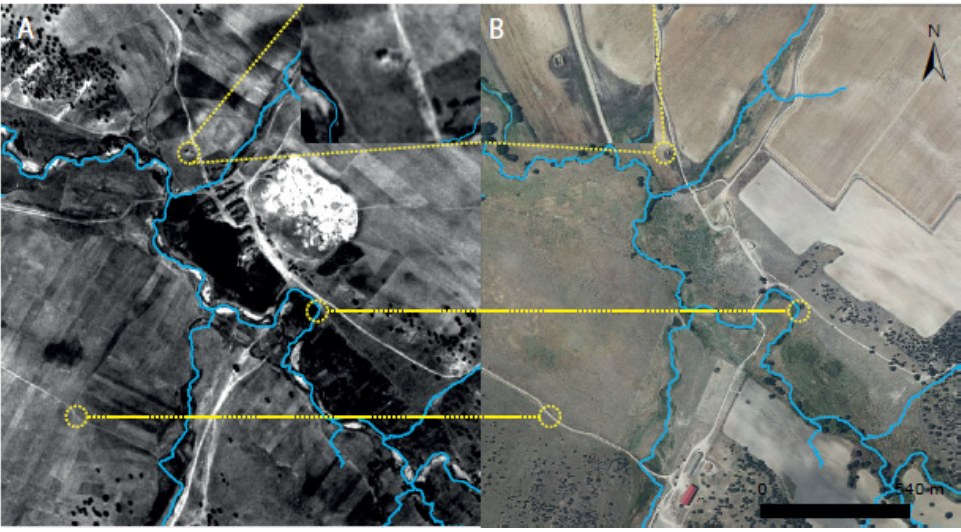
Figure 6. Control points used in georeferencing: ( A ) American flight photo; ( B ) 2017 Orthophoto. The main channel of the stream was plotted on the previously processed historical images with a polygonal shape. For practical purposes, the study sector was divided into time in the main channel (Equation (5)). In this case, four sections were defined (Figure 1).